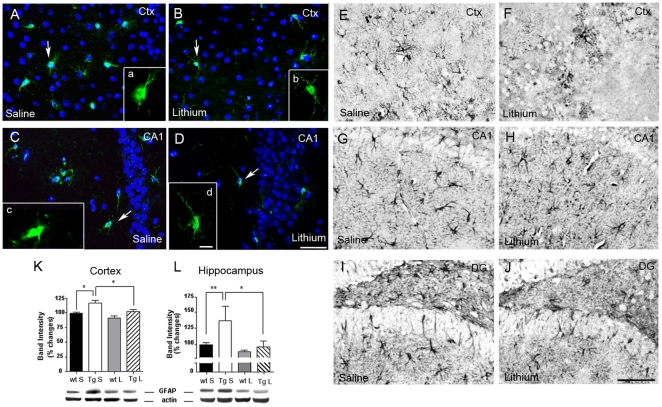
Lithium reduced glia activation in the 3-month-old TgCRND8 mouse brain.A–D: representative photomicrographs of merged fluorescent immunohistochemical analysis of IBA-1 (green) labelled microglial cells plus DAPI (blue) in the cortex (A,B) and CA1 area of the hippocampus (C,D) of saline-treated (A,C) and lithium-treated (B,D) TgCRND8 mice. Insets a-d: higher magnifications of the IBA-1 positive cells indicated by the arrows in each image. Note that microglial cells in the lithium treated mice have smaller cell bodies and thinner and elongated processes (magnified b and d images) than in saline controls, where microglial cells display swollen cell bodies and short and thick processes (magnified a and c images). Scale bar = 50 µm (A–D). Scale bar = 25 µm (a–d). E–J: representative photomicrographs of GFAP immunoreactivity in the cortex, CA1 and dentate gyrus of the hippocampus of saline- (E,G,I) and lithium- (F,H,J) treated TgCRND8 mice showing a reduced astrocytes reaction in the lithium group. Scale bar = 100 µm applies for all images. K,L: qualitative and quantitative analyses of GFAP Western blots in the cortex (K) and hippocampus (L) of saline- and lithium-treated Tg mice. Cortex: *P<0.05, saline-treated Tg vs saline-treated wt and vs lithium-treated Tg mice; hippocampus: **P<0.01 saline-treated Tg vs saline-treated wt mice, *P<0.05 saline-treated Tg vs lithium-treated Tg mice, one-way ANOVA plus Bonferroni's post hoc test. Ctx: cortex; DG: dentate gyrus.